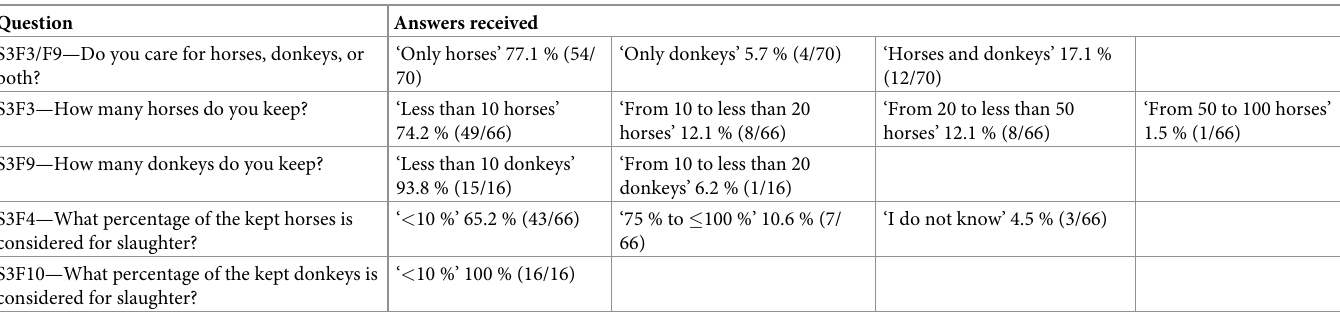
Table 2. Demographic description of kept equines and their slaughter